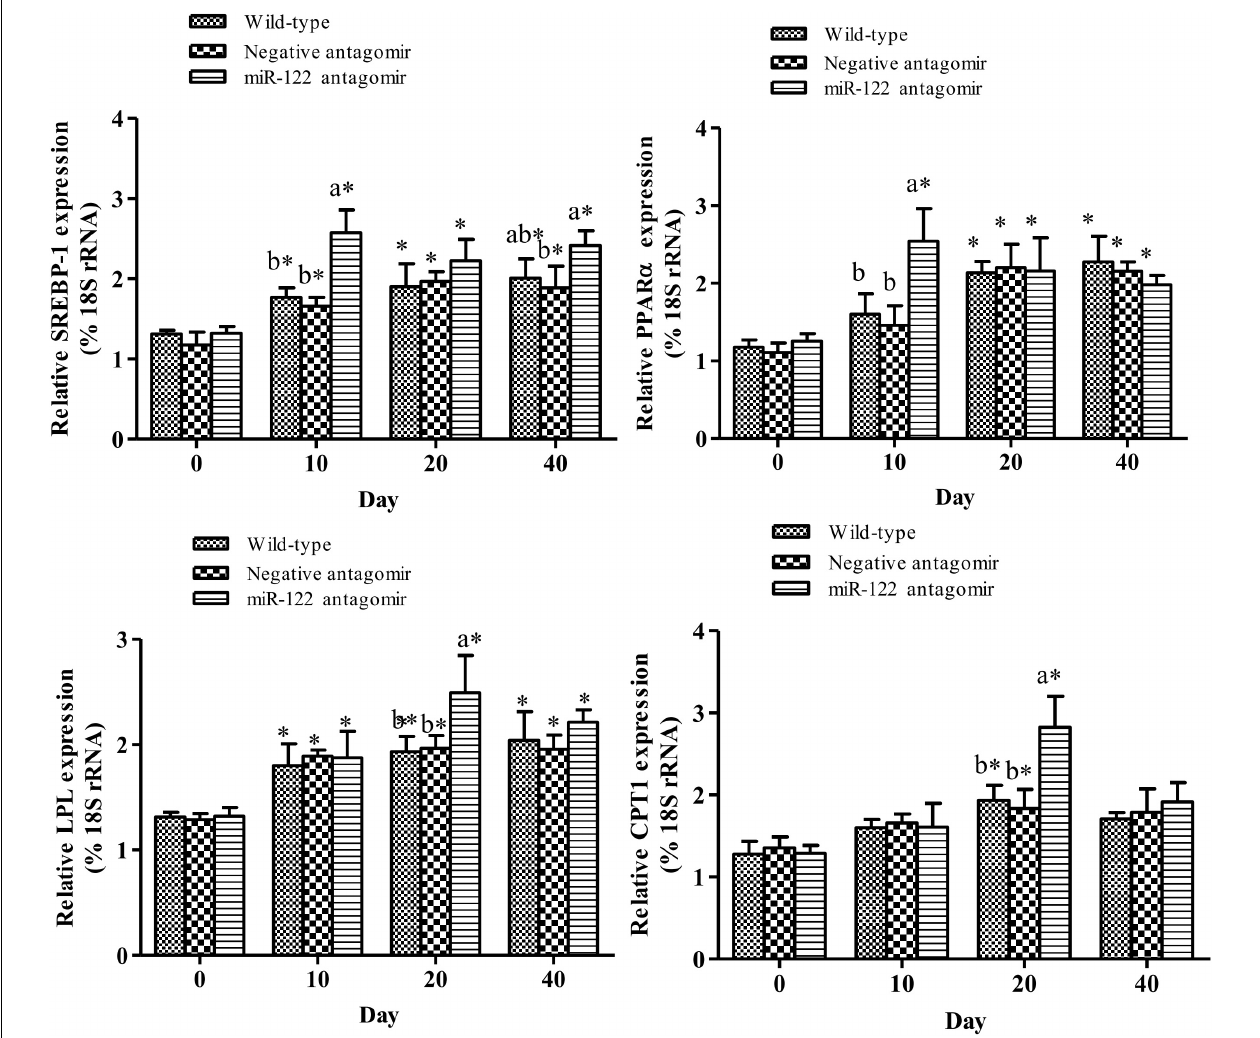
FIGURE 4 | Effect of hepatic SCD up-regulation on expression of genes related to lipid metabolism in GIFT. GIFT injected with PBS served as control. ∗ P < 0.05 indicates significant differences in each group among sampling points (paired-samples t test). The data were expressed as the relative change compared with the control group on day 0. Different lowercase letters show significant differences among treatments at each sampling point ( P < 0.05, Duncan’s multiple range